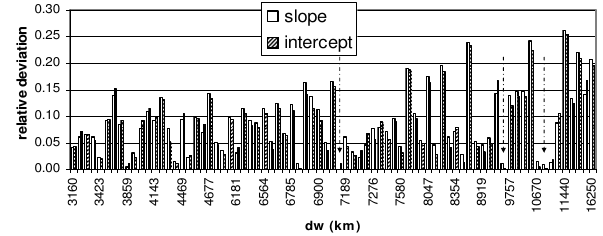
Fig. 8. Variation of deviation with distance d w . Figure 8 Variation of deviation with distance d w .